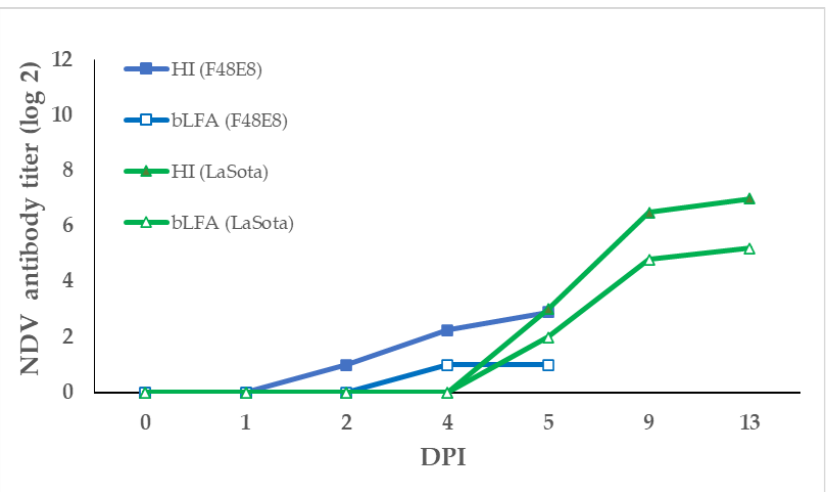
Figure 4. The dynamic change in NDV antibody in infected and vaccinated chickens. Serum samples were collected from the F 48 E 8 -infected and LaSota-vaccinated chickens at 1, 2, 4, 5, 9, and 13 DPI post-infected. The anti-NDV antibody titers of sera were then detected by the bLFA strip and HI test,